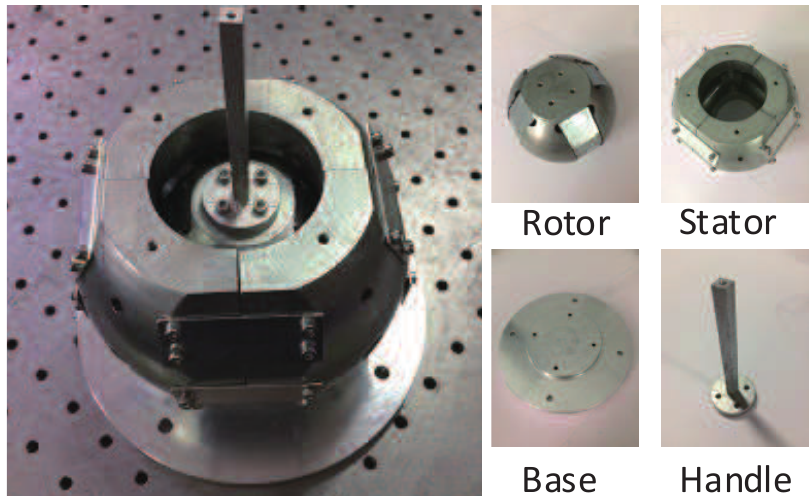
Figure 11. Overview of the developed research